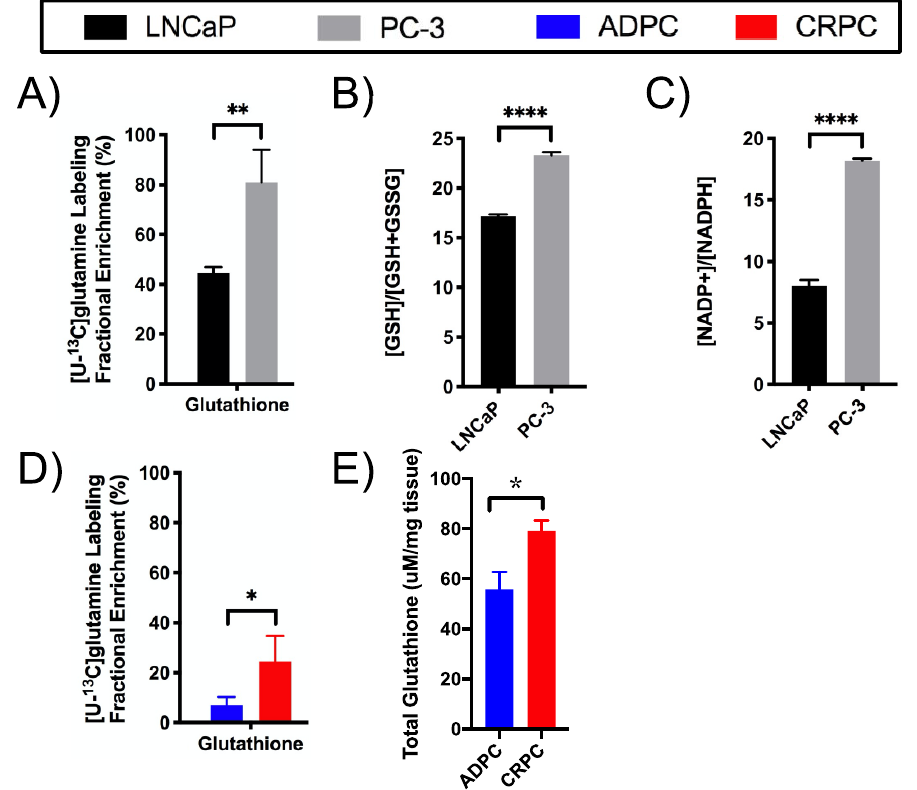
Figure 7. Glutathione redox capacity is upregulated in CRPC. Glutathione redox capacity was assessed in LNCaP and PC-3 cells based on ( A ) fractional enrichment of glutathione in cells labeled with [U- 13 C]glutamine, ( B ) ratio of reduced glutathione (GSH) relative to total glutathione (GSH + GSSG), and ( C ) intracellular NADP + /NADPH. Glutathione redox balance was assessed in ADPC and CRPC TRAMP tumors based on ( D ) fractional enrichment of glutathione in tumors labeled with [U- 13 C]glutamine and ( E ) total glutathione (* p < 0.05, ** p < 0.01, **** p < 0.0001). 2.7. Elevated Glycolysis Observed in CRPC vs. ADPC Using HP [1- 13 C]pyruvate